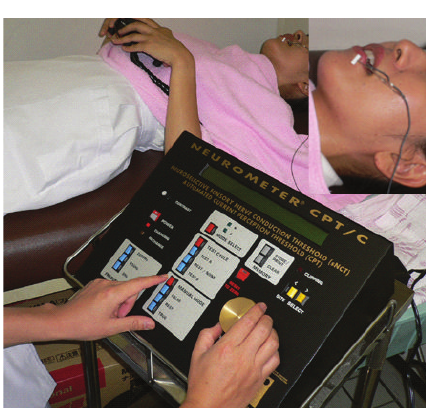
Figure 8: Current perception threshold.